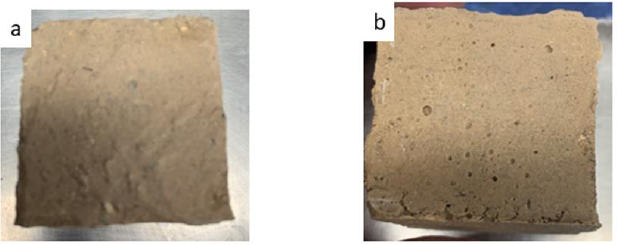
Figure 15. MKPCs with the optimum compositions ( a ) before, and ( b ) after water resistance testing for one day.